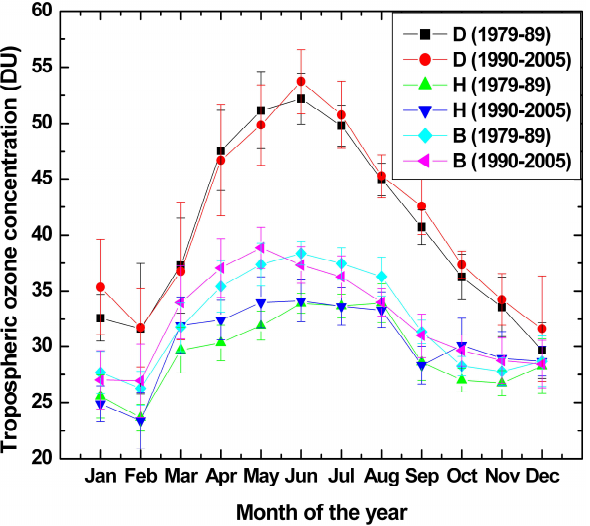
Fig. 3. Annual variation in averaged TOR over the three major in- land cities Delhi, Hyderabad and Bangalore of India, for the periods 1979–1989 and 1990–2005. The vertical bars show one sigma stan- dard